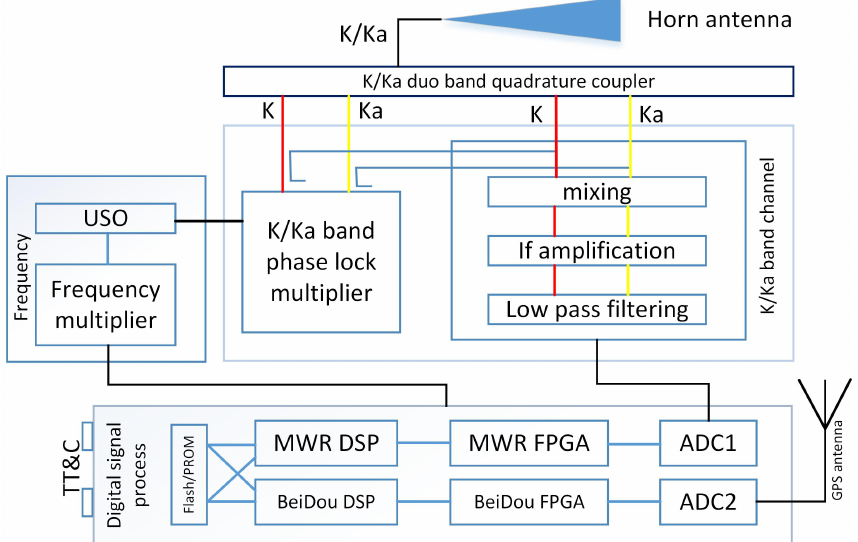
Figure 2. Block schematic of the microwave ranging (MWR) system, mainly including a K/Ka horn transceiving antenna with quadrature coupler, frequency reference unit, K/Ka-band microwave channel, and digital signal processing platform.